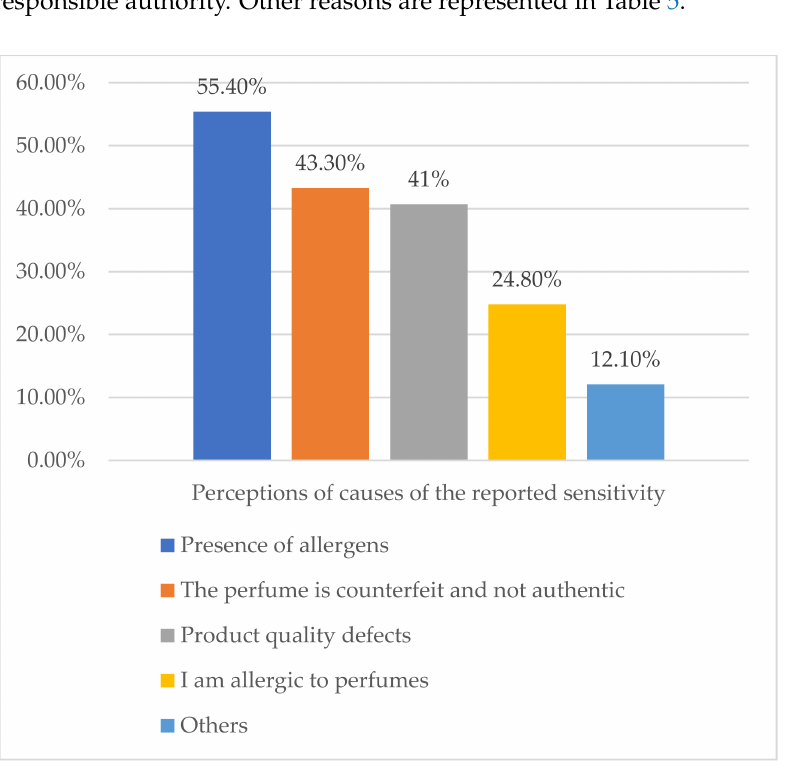
Figure 2. Perceptions of causes of the reported sensitivity ( n =